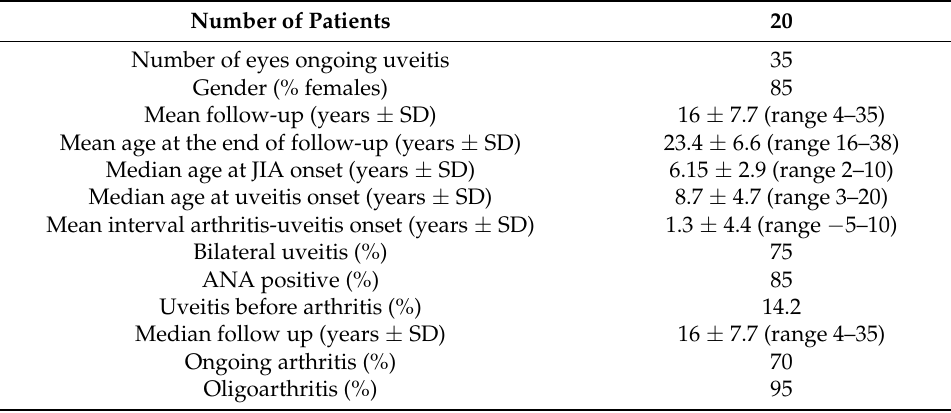
Table 1. Demographic and clinical characteristics of